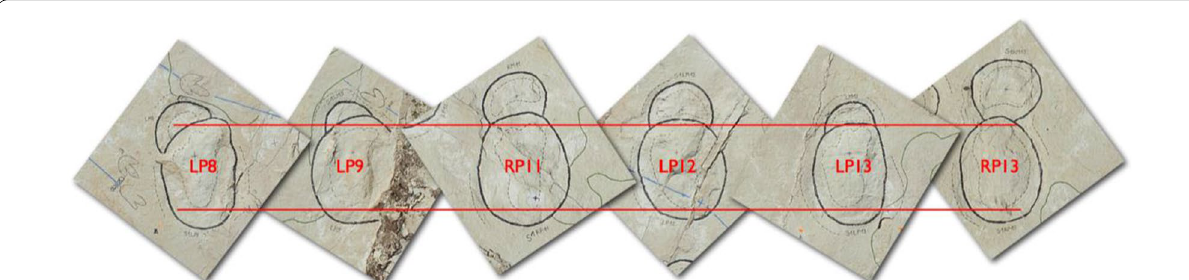
Fig. 4 Orthophotographs of well-preserved sauropod tracks from the BEB-500-S1 trackway of the Courtedoux-Béchat Bovais tracksite (Marty et al., 2007). The displacement rims (solid line) are roughly elliptical and the manus tracks are partly overprinted. Within the roughly elliptical displacement rim, the actual outline of the foot is often, but not invariably, apparent (outlined by dashed lines). The displacement rim is more reliably present and therefore used as the basis for locating track ‘centers’. The red lines are separated by 50